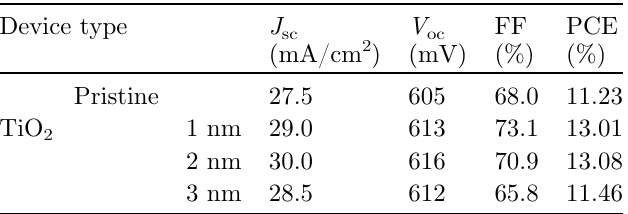
Table 1. Solar cell parameters, J PEDOT:PSS/n-Si solar cells with of TiO thicknesses.